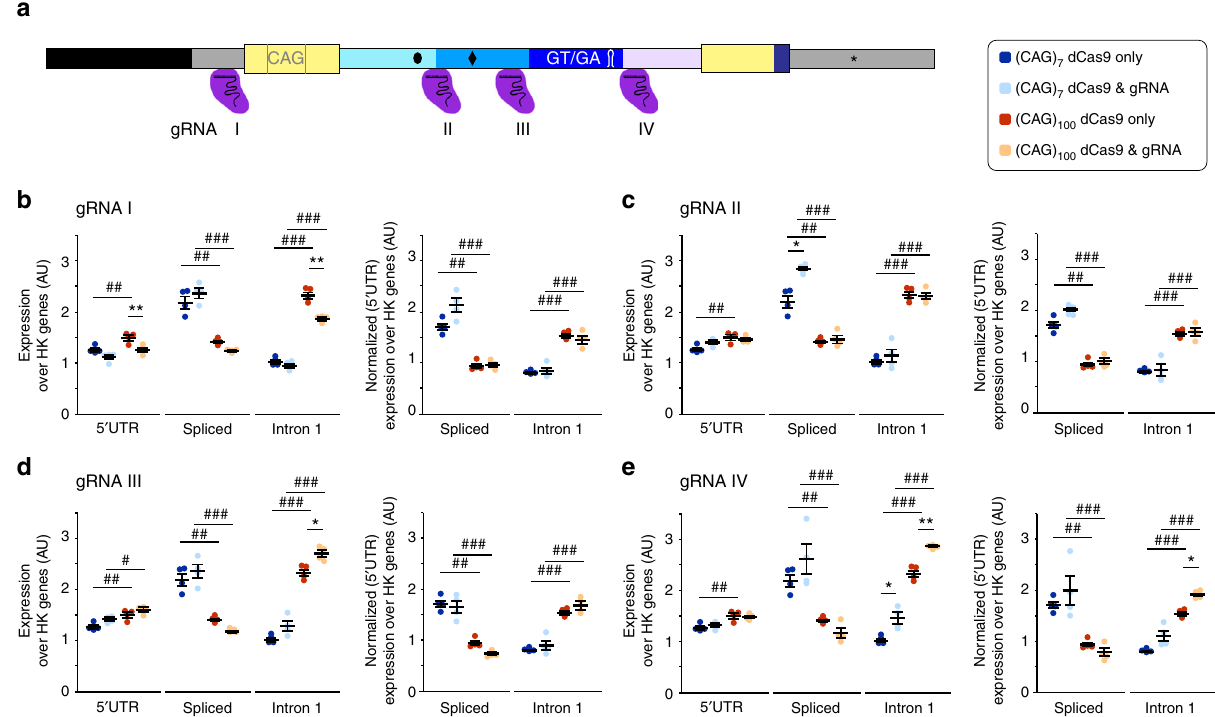
Fig. 6 CRISPR/dCas9 induced obstacles of transcription increase the amount of incomplete splicing of Htt . a Schematic showing the binding sites of the four different guide RNAs (gRNA I-IV). b – e Transcript analysis of minigene sequences. Left panels show expression levels standardized to housekeeping genes. Data in the right panels are additionally normalized to 5 ′ UTR levels for the respective gRNA treatment. Individual data points and the mean ± s.e.m. are shown. n = 4 independent experiments/CAG-length/gRNA, two-way ANOVA with Tukey post hoc test. gRNA for given CAG-length: * p < 0.05, ** p < 0.01, *** p < 0.001. gRNA x CAG-length # p < 0.05, ## p < 0.01, ### p < 0.001. b gRNA I treatment reduced the level of minigene transcripts (5 ′ UTR).